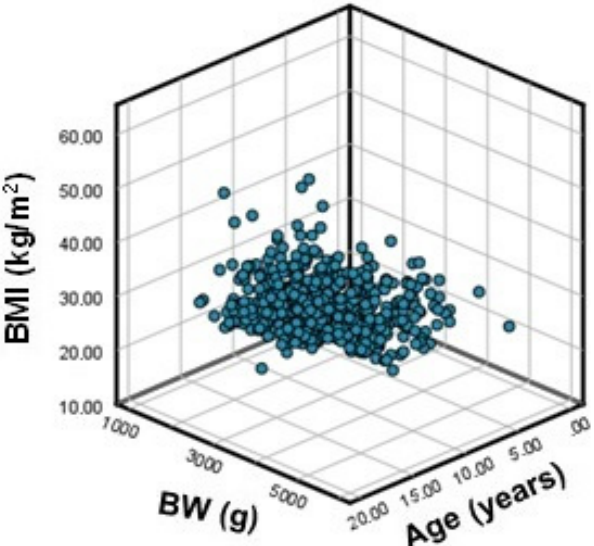
Figure 2. Correlation between BMI, age, and